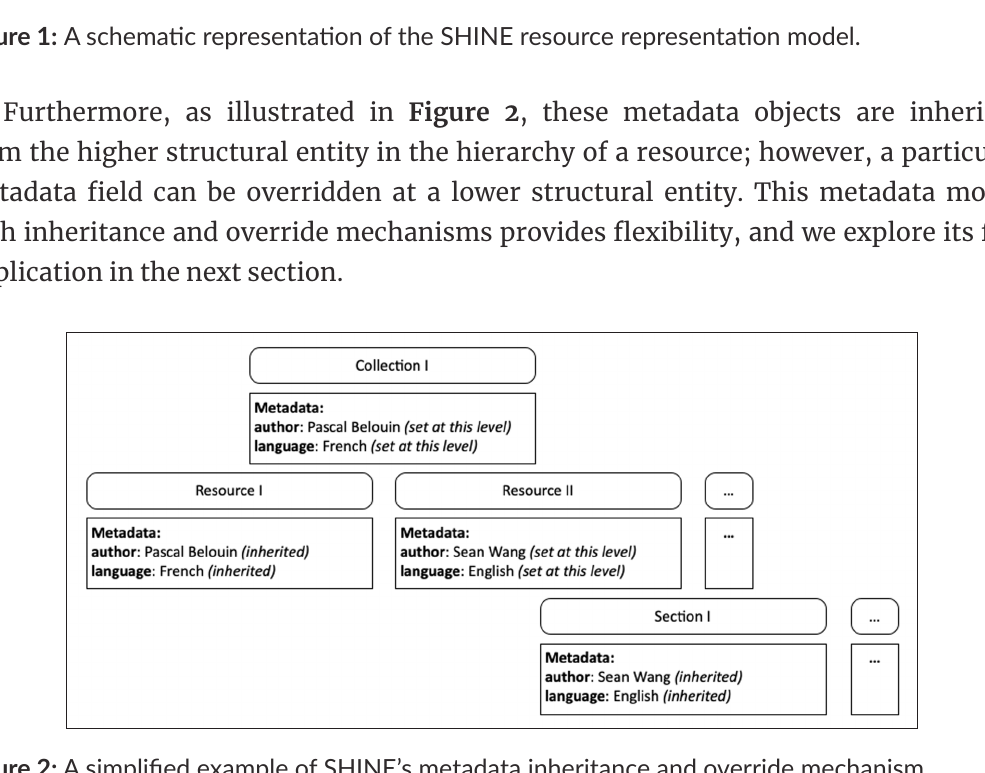
Figure 2: A simplified example of SHINE’s metadata inheritance and override